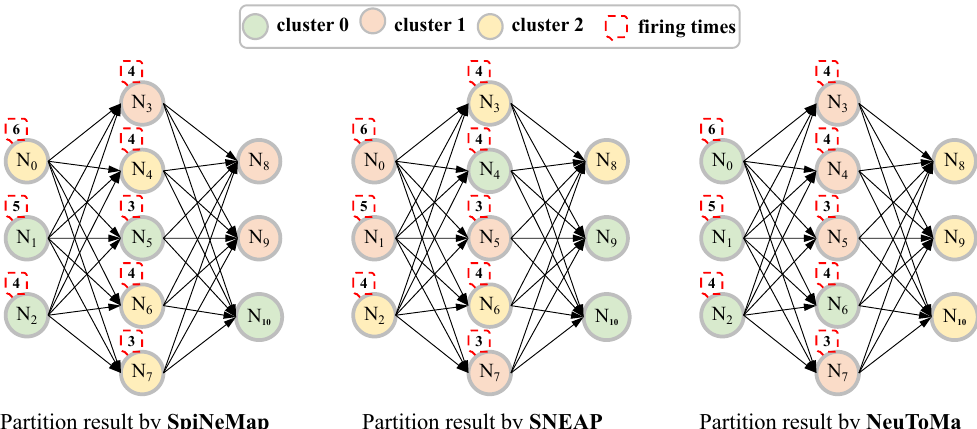
Figure 1. An SNN is partitioned by SpiNeMap [13], SNEAP [14], and NeuToMa, respectively. The capacity of a single core is set to